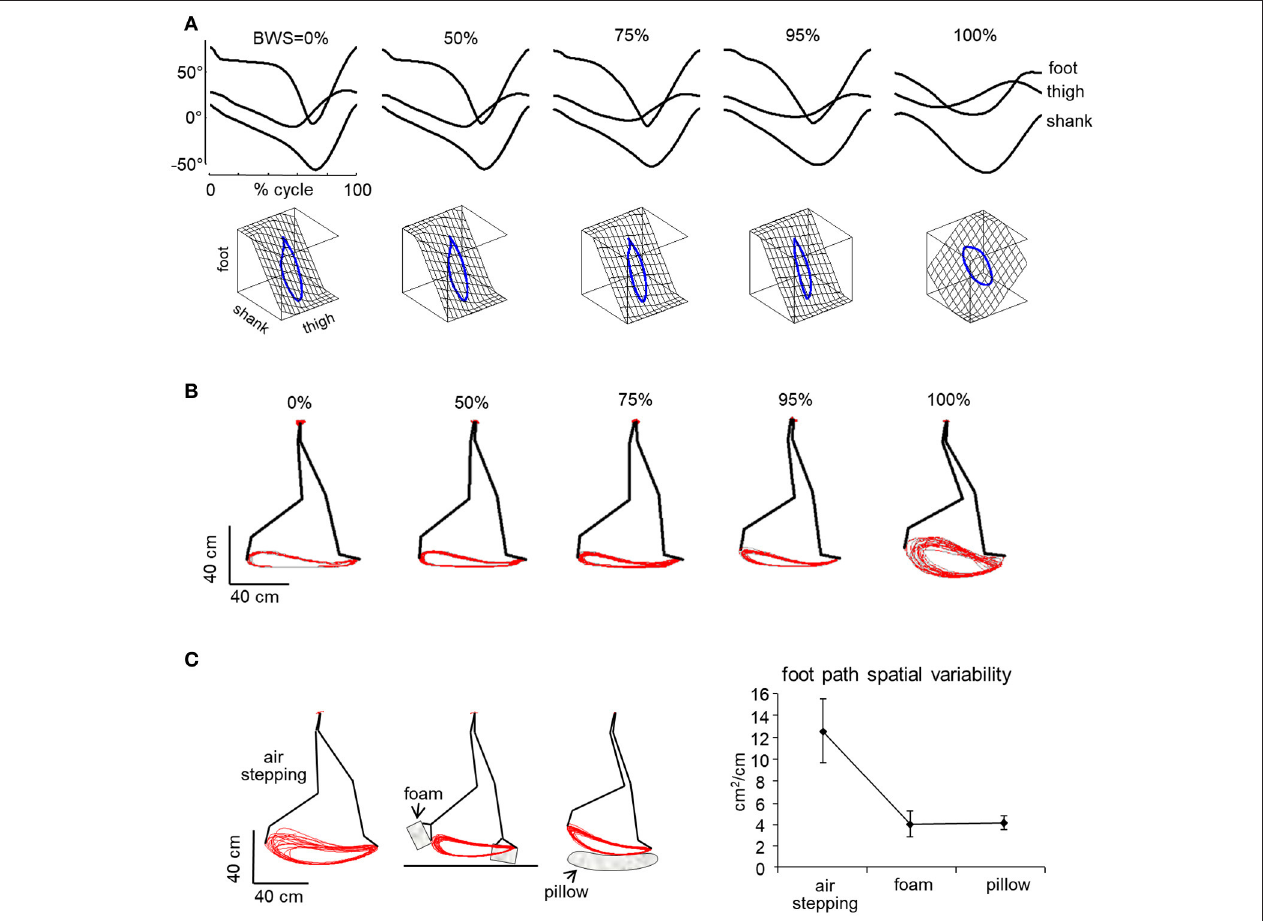
FIGURE 5 | Effect of simulated reduced gravity on walking kinematics. (A) examples of ensemble-averaged elevation angles of the lower limb segments in one adult subject walking at 3 km/h at different BWS levels (100% refers to air-stepping) and corresponding 3-dimensional gait loops obtained by plotting the elevation angles 1 vs. the others. Note similar kinematics and covariance plane orientation in all BWS conditions except for air-stepping. Adapted from Ivanenko et al. (2002). (B) shape and variability of endpoint path in 1 subject over 12 consecutive step cycles for trials performed at different BWS levels. (C) effect of minimal contact forces provided by a foam-rubber taped under the subjects’ feet or when touching the pillow during air-stepping. Right panel—spatial variability of the foot trajectory (foot path tolerance area, mean ± SD over all subjects). Note that the shape and variability of the foot path is comparable in all conditions except in air-stepping, where variability is much higher (B) . Variability decreased substantially in the presence of minimal surrogate contact forces relative to standard air-stepping (C)